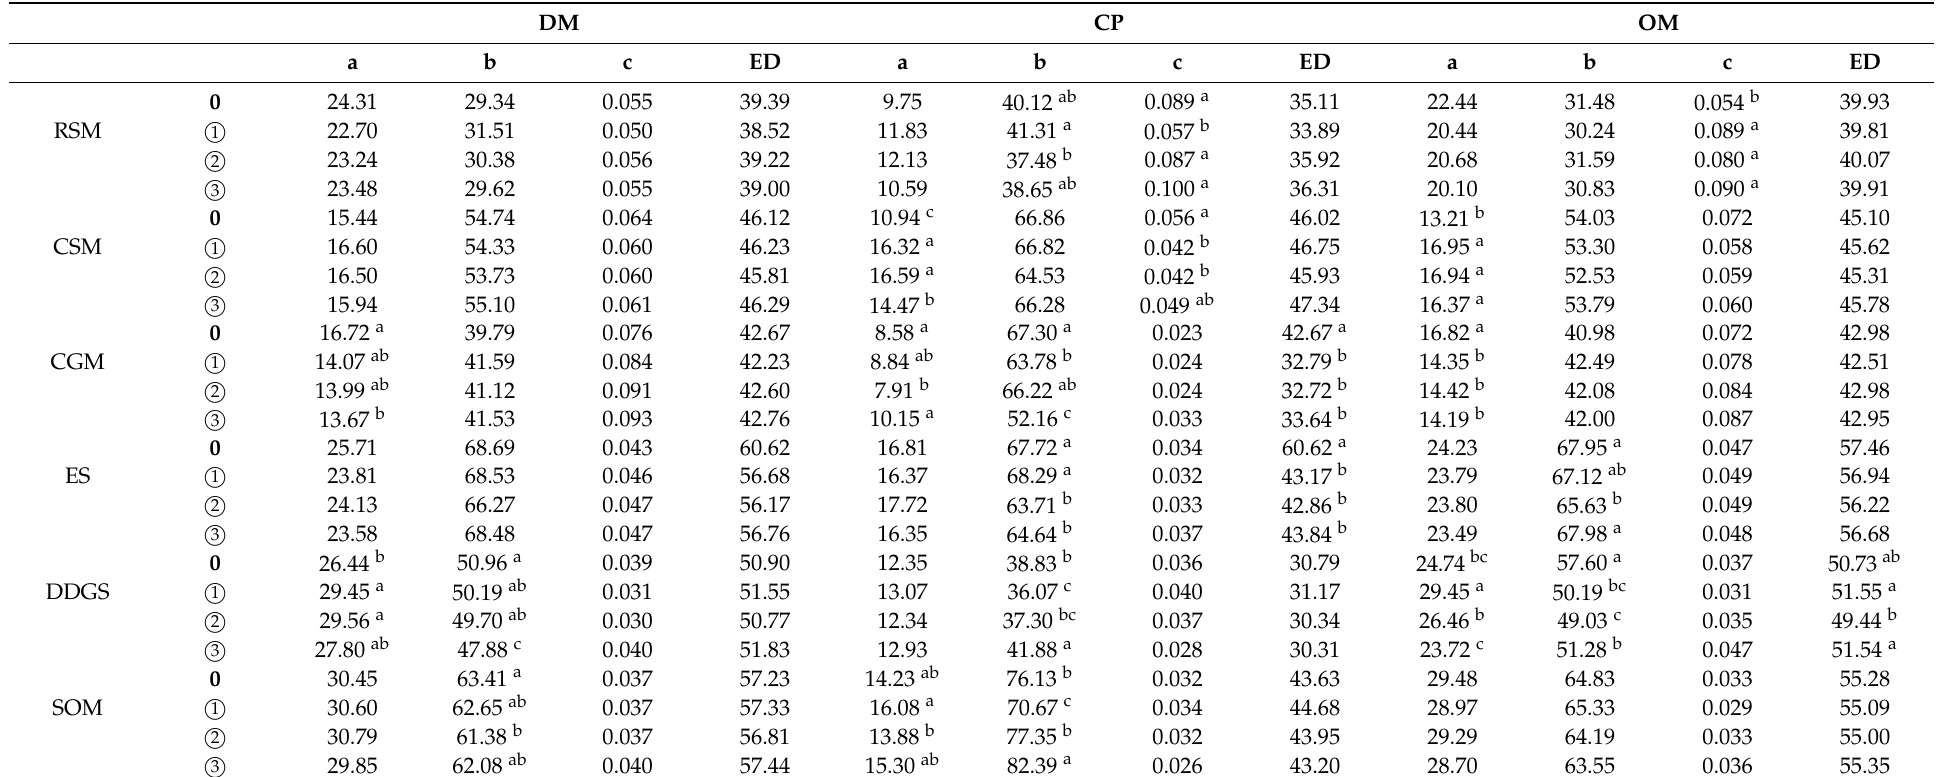
Table 3. The degradation parameters of dry matter, crude protein, and organic matter in rumen of six protein feeds